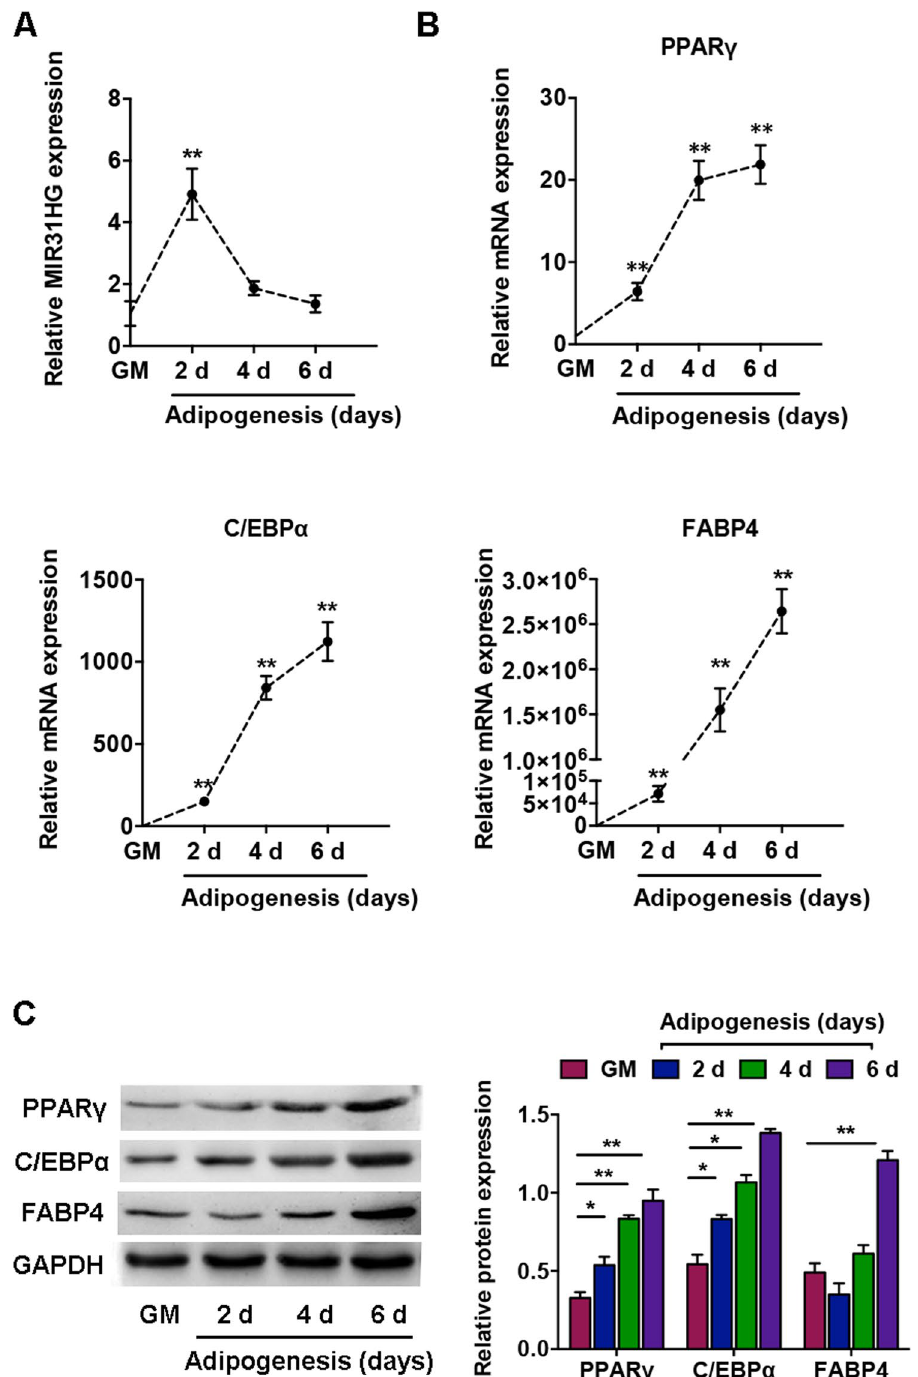
Figure 2. Dynamic Expression profile of MIR31HG during adipogenic differentiation of hASCs. ( A ) Relative expression of MIR31HG on day 2, 4, and 6 during differentiation as determined by qRT-PCR analysis normalized to the undifferentiation group cultured in growth medium (GM). ( B ) Relative mRNA expression levels of the adipogenic markers PPAR γ , C/EBP α , and FABP4 at the indicated time points, as in ( A ). Gene expression plotted as fold-change relative to the GM group. ( C ) Western blot analysis (left) and quantification (right) of protein expression of PPAR γ , C/EBP α , FABP4, and the internal control GAPDH at the indicated time points, as in ( A ). Results are presented as mean ± SD ( * P < 0.05, ** P < 0.01 compared to the undifferentiated